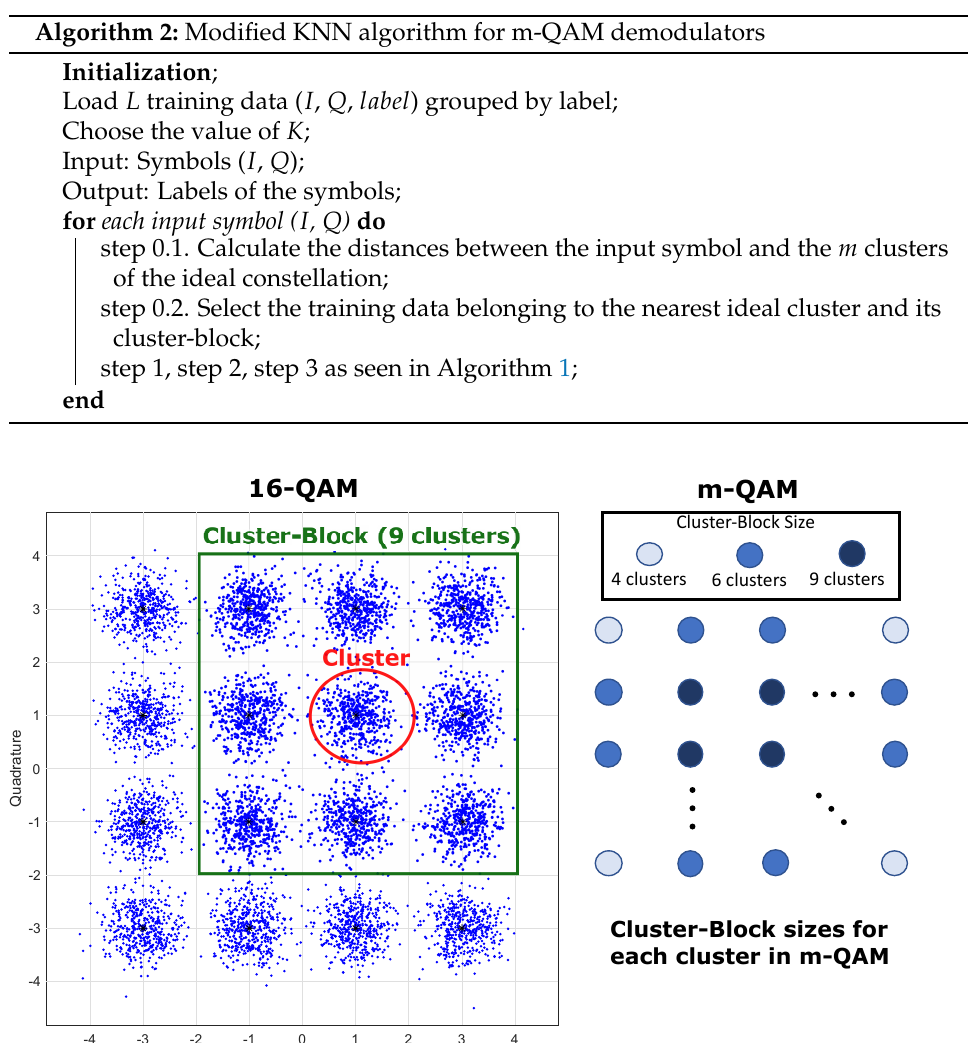
Figure 4. On the left side, a cluster-block example in a 16-QAM for the modified KNN algorithm, according to the 8-conected neighbors rule. On the right side, the generalization of each cluster-block’s sizes in an m-QAM constellation, the only possible cluster-block sizes are 4, 6, or